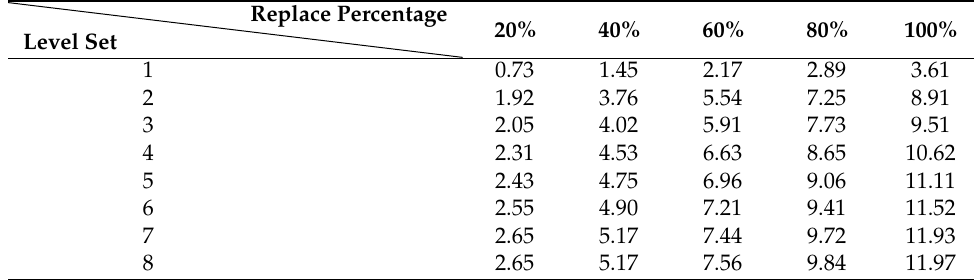
Figure 16. SAPG system 7th thermal economy.